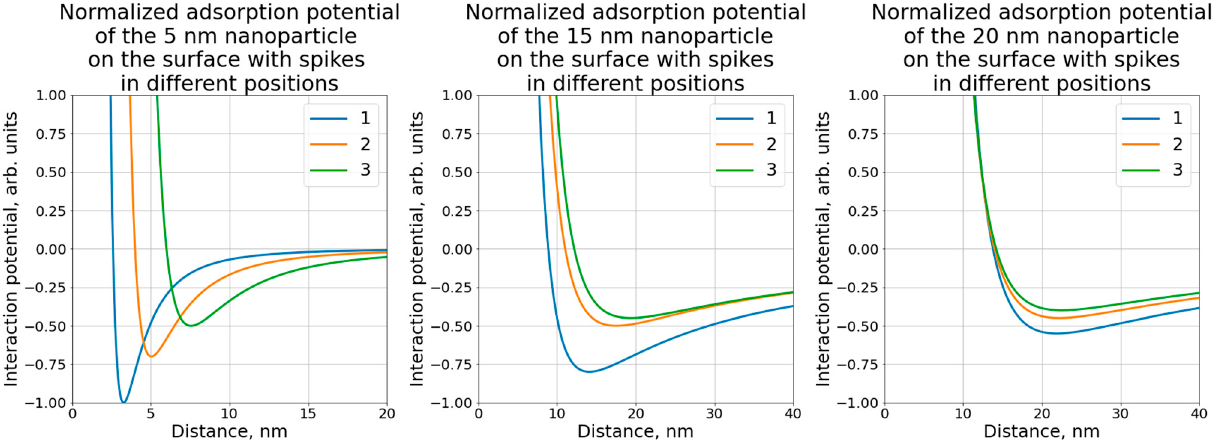
Figure 4. Interaction potential between the nanoparticle and the virus depending on the nanoparticle location near the virus spike (curve 1 corresponds to site 1 in Figure 3; curve 2 corresponds to site 2 in Figure 3; curve 3 corresponds to site 3 in Figure 3). All the results were normalized to the deepest energy minimum corresponding to case ‘1 ′ of 5 nm nanopar- ticles.